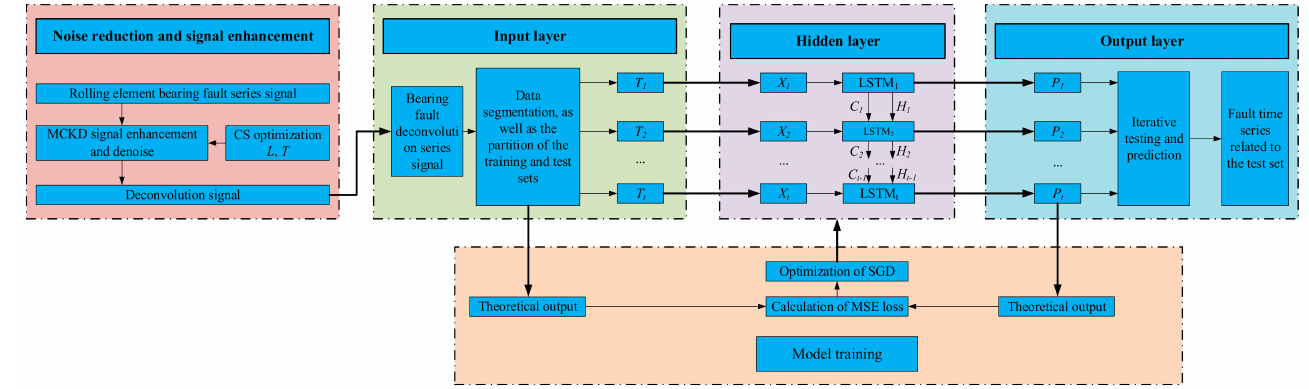
Figure 2. Flow chart of the prediction process of rolling element bearing fault time series based on the optimized